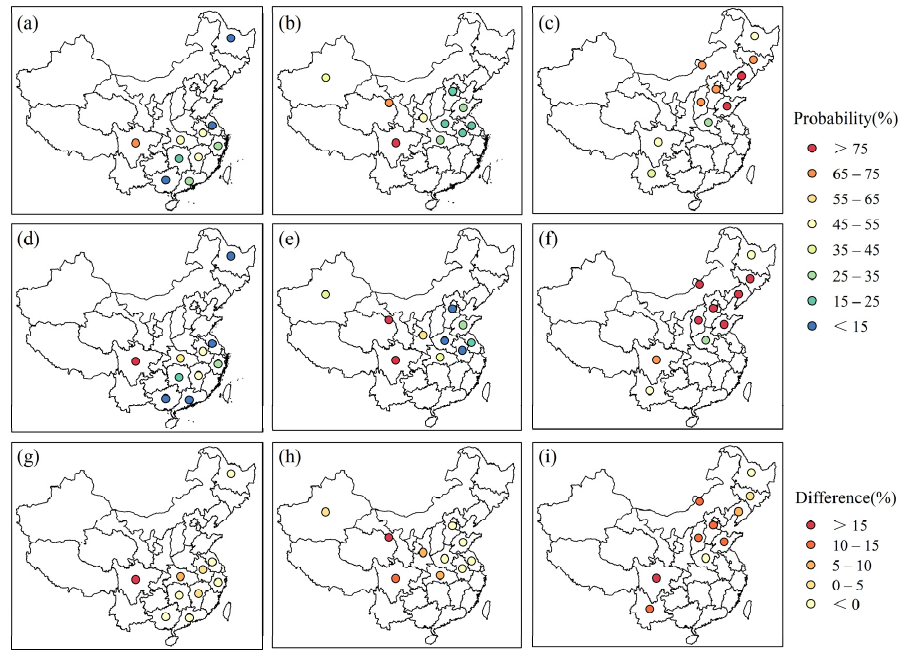
Figure 9. Probability of yield reduction for rice ( first column), wheat ( second column), and maize ( third column) at 1.5 °C ( top row) and 2 °C ( middle row) global warming under SSP5-8.5. The dif- and maize ( third column, c , f , i ) at 1.5 ◦ C ( top row, a – c ) and 2 ◦ C ( middle row, d – f ) global warming ference in the probability of yield reduction between 1.5 °C and 2 °C global warming is shown in under SSP5-8.5. The difference in the probability of yield reduction between 1.5 ◦ C and 2 ◦ C global the bottom row. warming is shown in the bottom